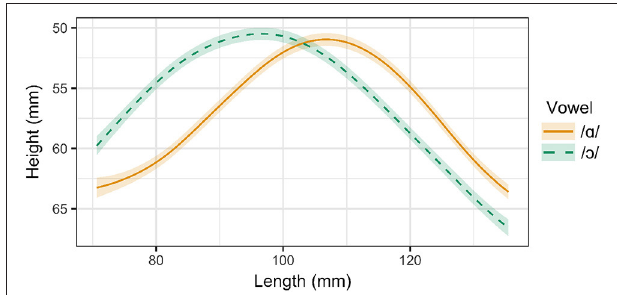
FIGURE 3 | Main effect curves for SSANOVA model of /A/ and /O/ for Speaker 1. Shading indicates 95% Bayesian confidence interval.